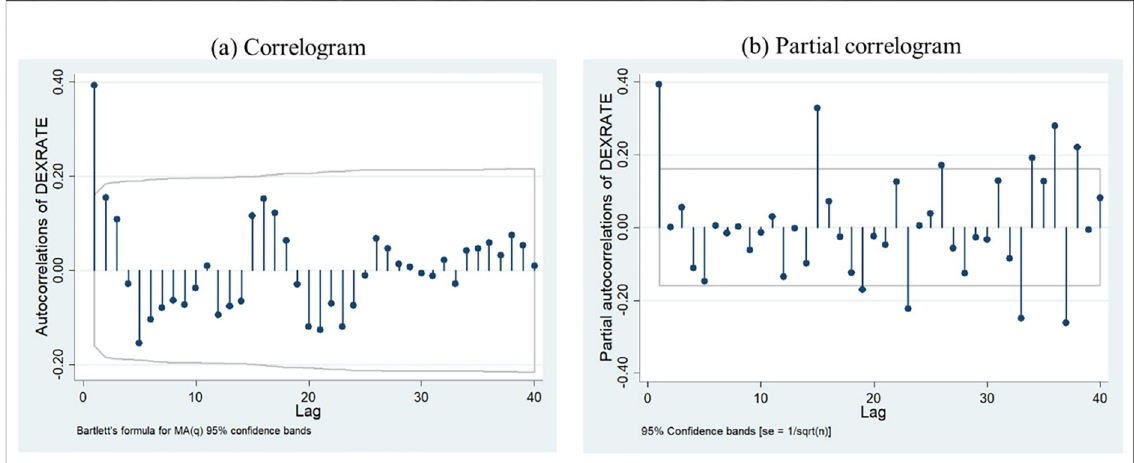
Fig 3. Correlogram and partial correlogram of exchange rate. Source: Authors’ construct based on the collected